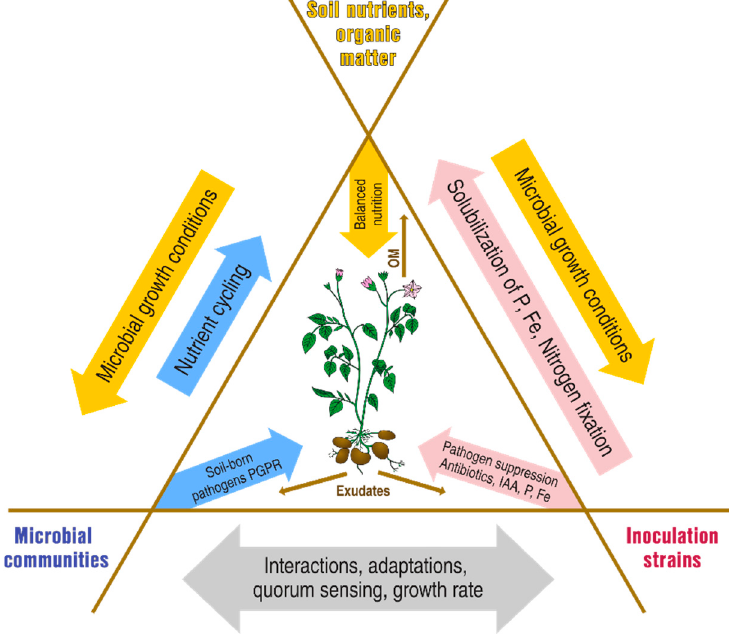
Figure 1. Interactions of soil components, microbial communities, introduced biocontrol strains and potato plants in a system affected by common scab.